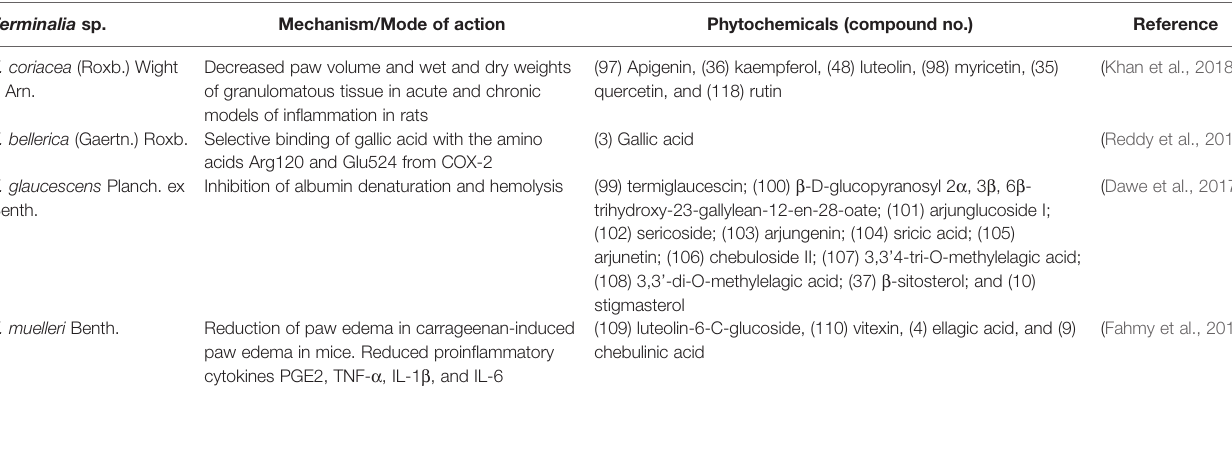
TABLE 5 | Summarization of the antiin fl ammatory studies of different Terminalia species. Terminalia